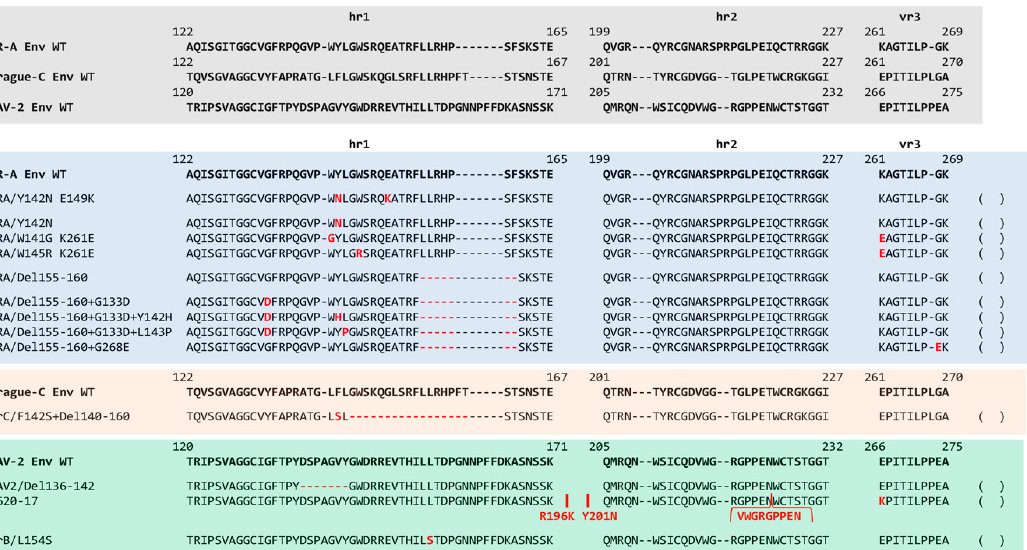
Figure 8. A summary and comparison of the ASLV SU glycoprotein wild type and escape mutations identified using various genetic-based selections strategies on limiting the entry and subsequent production of replication-competent ASLVs. Comparison of the SR-A, Prague C, and RAV-2 hr1, hr2, and vr3 hypervariable regions of the SU glycoproteins. The sequence alignments were done using the ClustalW program in MacVector 14.5.3: gaps are noted with black dashes ( − ). The identified mutations are shown in red text; deletions are shown with red dashes ( − ). The sequence numbering is provided relative to each ASLV Env protein.